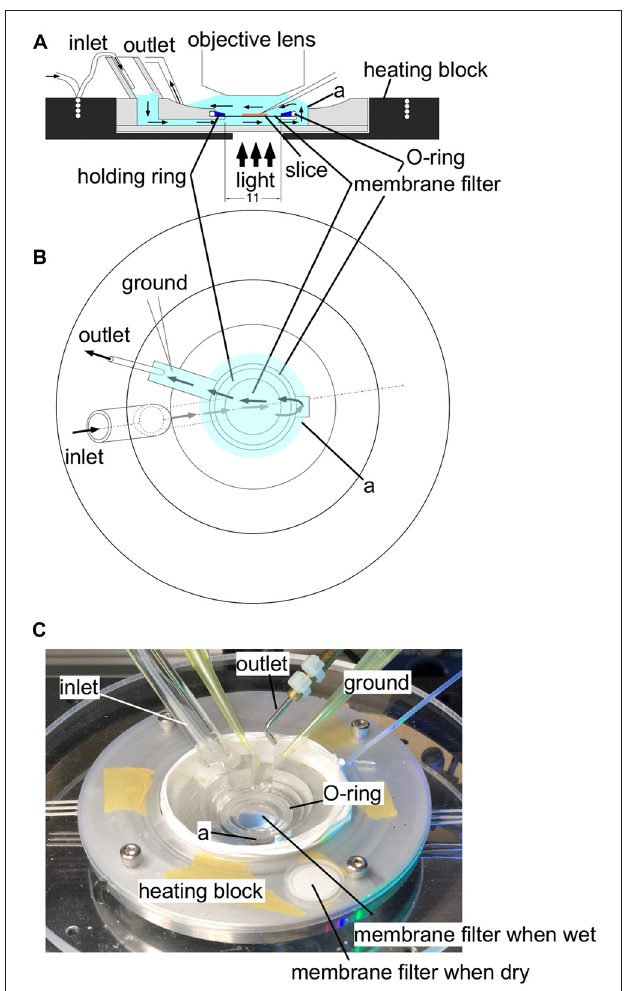
FIGURE 1 | An illustration of the experimental recording chamber system. (A) A side view of the recording chamber. An aluminum heating block (black) surrounds the plexiglass recording chamber. A thin tubing embedded in the heating block supplies gassed ACSF to the recording chamber through a wide bubble-trapping tube. The ACSF then flows beneath the specimen held by a polytetrafluoroethylene (PTFE) membrane filter (13 mm in diameter) fixed to a thin (1 mm in height) plexiglass holding ring. The ACSF flows upward through a connecting channel and over the specimen. The tight sealing of the O-ring and the plexiglass holding ring ensures a single stream of ACSF, so that the ACSF supply gas and glucose from both sides of the specimen. The ACSF is then sucked by the outlet tubing. (B) A top view of the chamber system. Arrows represent the flow of ACSF. (C) A photograph of the experimental recording system. In the center of the recording chamber, a wet membrane filter was placed to show that the membrane filter becomes transparent so that transmitted illumination is possible. A membrane filter was placed outside the recording chamber before use to show the membrane filter when it is dry for comparison. Label (a) shows the well connecting the fluid channel beneath the membrane filter and the top space to cover a slice. A glass microcapillary tube (5- µ m opening diameter, filled with ACSF, 1 MOhm) was used as a monopolar stimulating electrode and a recording electrode for field potential recordings. The electrophysiological recording system was controlled with a procedure developed for Igor Pro (WaveMetrics Inc., OR, USA).